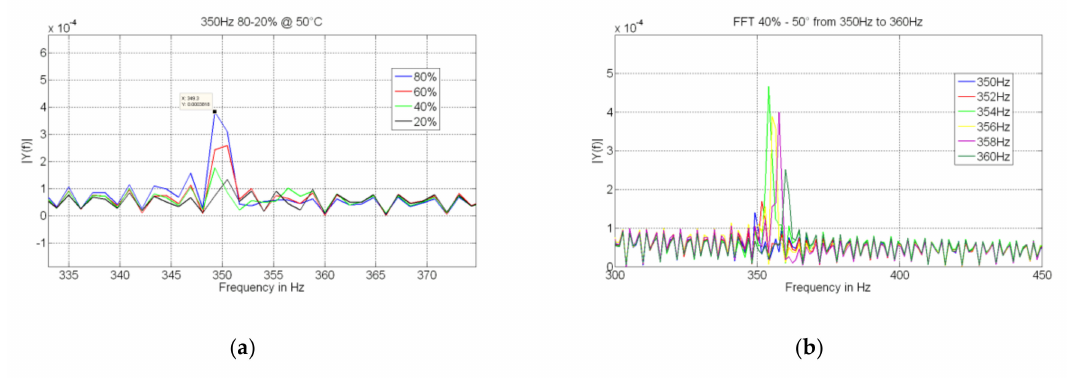
Figure 9. ( a ) FFT of the output of the bridge at 350 Hz (50 ◦ C); ( b ) analysis around the mechanical resonance (at 40%, 50 ◦